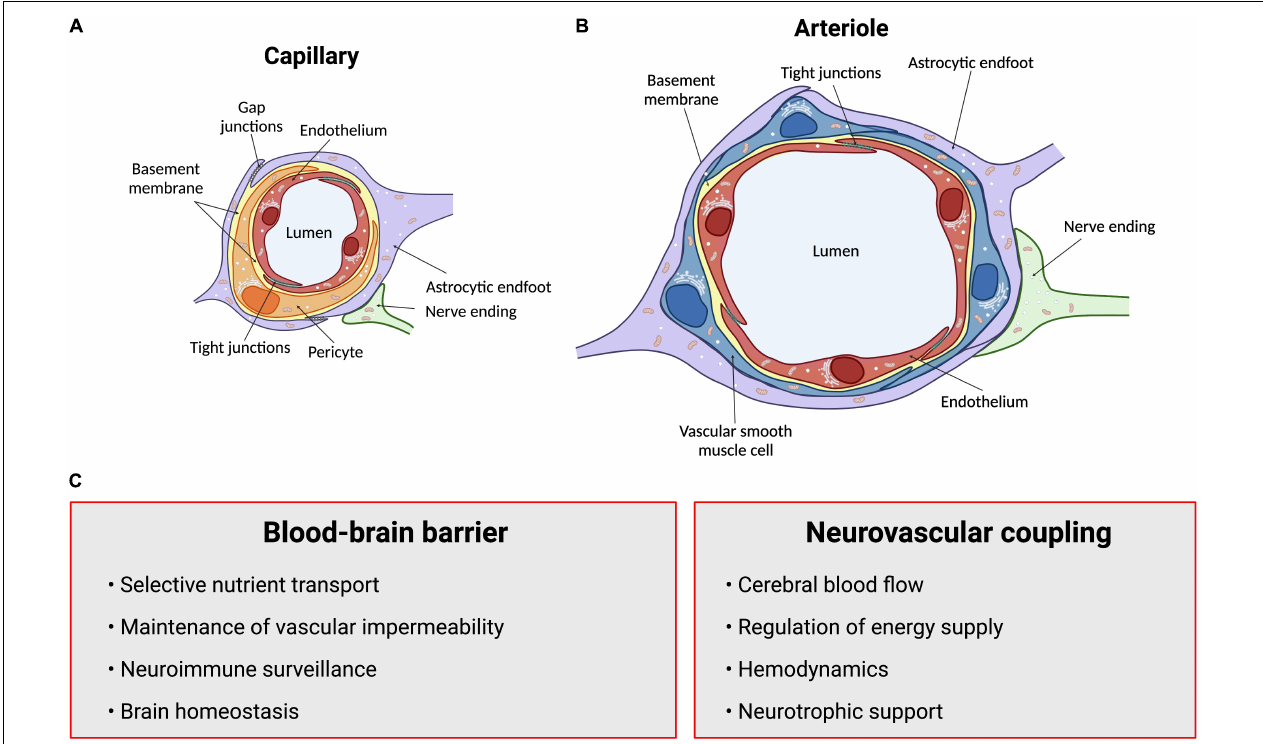
FIGURE 1 | Summary of structures and functions of the neurovascular unit (NVU). The anatomical substrate for regulation of cerebral blood flow and the blood-brain barrier is a multicellular system consisting of neurons, pericytes, smooth muscle cells, astrocytes and endothelial cells known as the NVU. (A) Intracerebral capillaries lack vascular smooth muscle cells but are partly covered by contractile pericytes. (B) At the level of intracerebral arterioles, the endothelium is fully covered by a single layer of vascular smooth muscle cells, which provide contractile properties to the arteriole. Astrocytes send their processes called endfeet around both capillaries and arterioles, providing support as well as a functional connection to surrounding parenchyma. (C) Summary of functions of the blood-brain barrier and neurovascular coupling. Arrows point to neurovascular unit components. Figure made using BioRender .